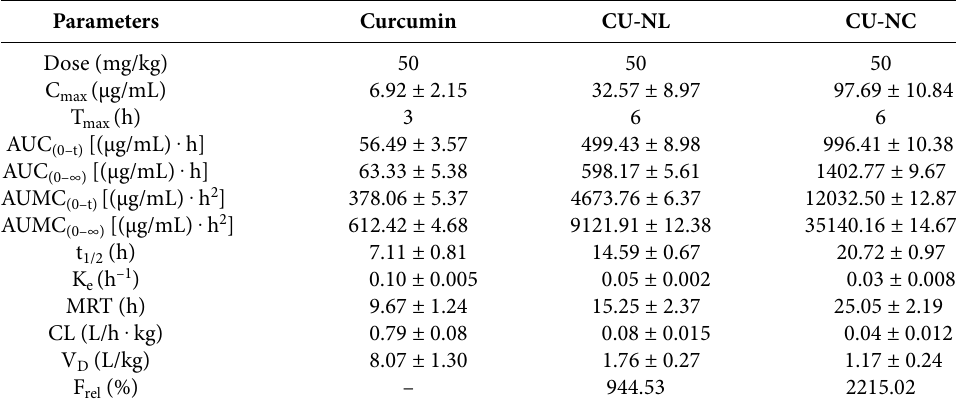
Table 7. Estimated pharmacokinetic parameters of curcumin, CU-NL, and CU-NC after oral administration in plas- ma samples of Wistar albino rats